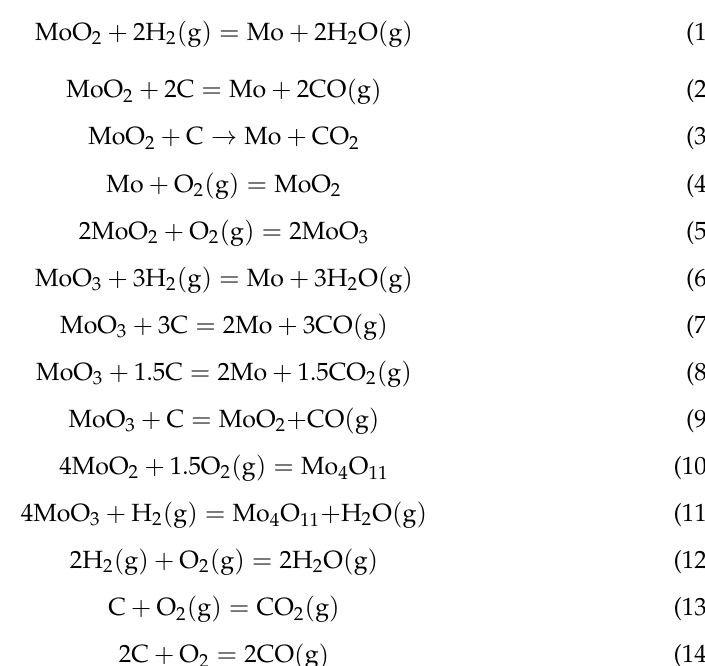
Figure 12. During sintering C-O reaction or H-O reaction, possible reactions [65]